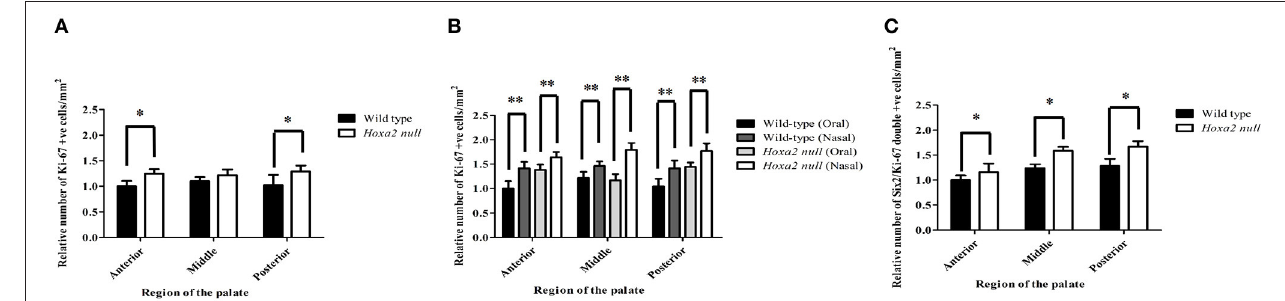
FIGURE 6 | The densities of proliferating, Ki-67 positive and Six2/Ki-67 double-positive mesenchyme cells are elevated in Hoxa2 − / − palatal shelves compared to wild-type. (A) Relative numbers of Ki-67 positive palatal mesenchyme cells per mm 2 in coronal sections taken from anterior, middle and posterior regions of E13.5 wild-type and Hoxa2 − / − palatal shelves. In the anterior and posterior regions, the density of proliferating palatal mesenchyme cells was significantly higher in Hoxa2 − / − palatal shelves compared to wild-type. (B) In both wild-type and Hoxa2 − / − palatal shelves, the density of proliferating palatal mesenchyme cells was consistently higher in the nasal half vs. the oral half of the palatal shelf. (C) Relative numbers of Six2-positive mesenchyme cells that co-expressed Ki-67 (i.e., were actively proliferating) in the anterior, middle and posterior regions of Hoxa2 − / − palatal shelves compared to wild-type. Bar graphs represent mean ± SEM; n = 4 biological replicates. * p < 0.05, ** p < 0.01.